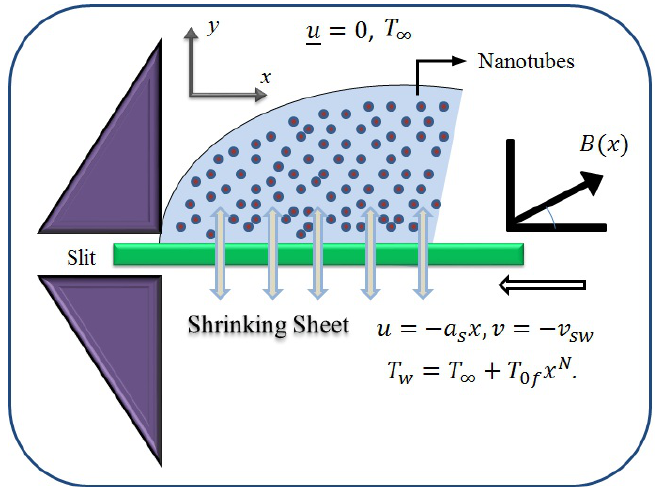
Figure 1. The physical viewpoint of the concept.